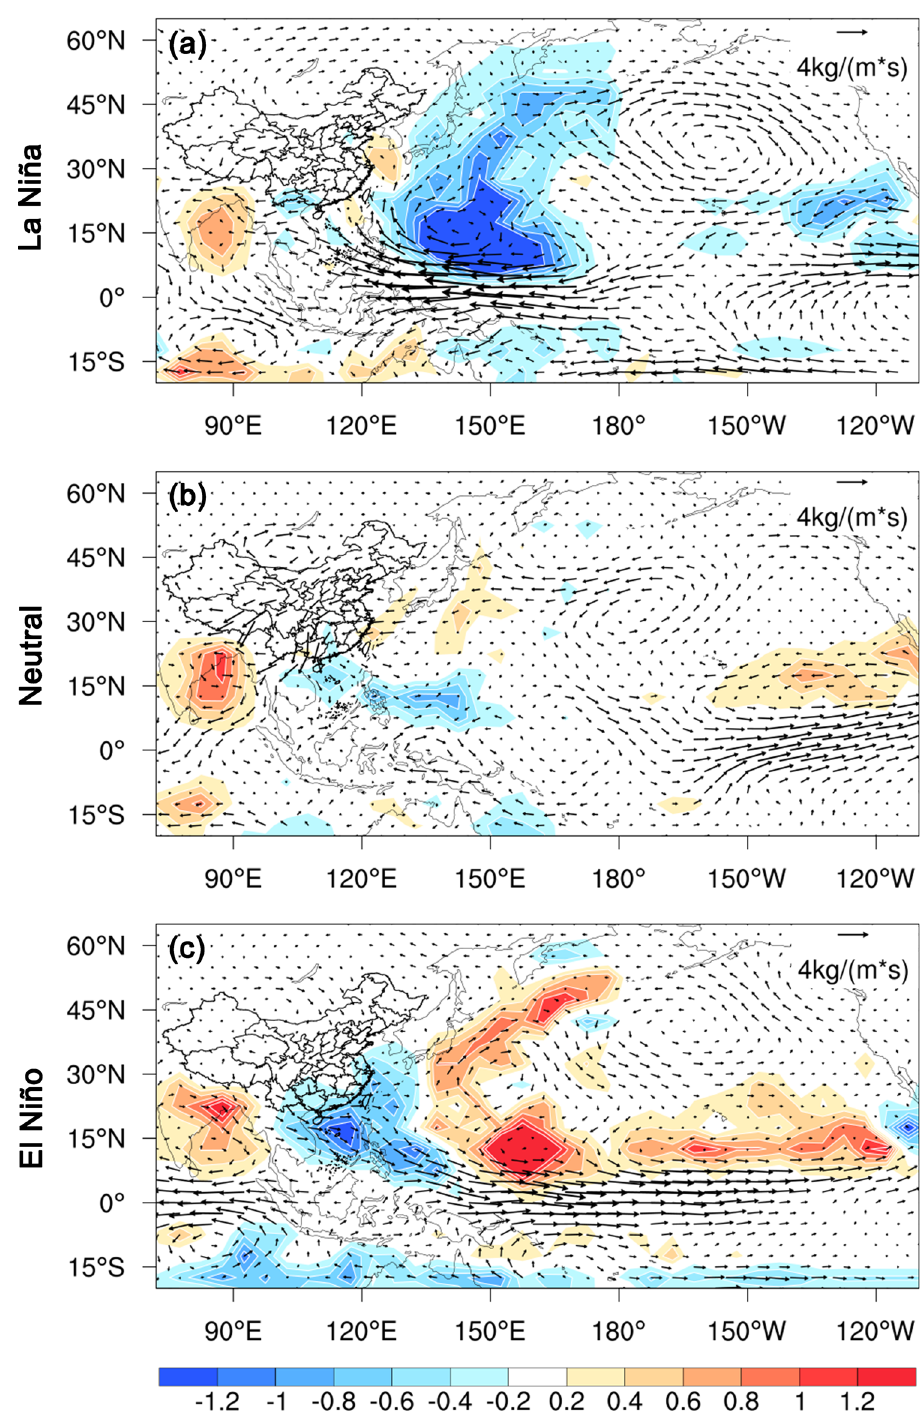
Fig. 9 Composited moisture flux (g/m/s) anomalies (arrows) and tropical cyclone (TC) track density anomalies (shadow) during La Nin˜a phase ( a ), neutral phase ( b ), and El Nin˜o phase ( c ). TC track density was calculated by binning the longitude and latitude of